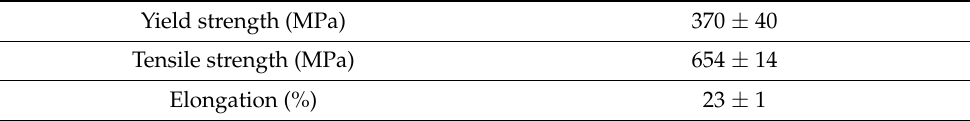
Table 2. The main mechanical properties of DP600 [17].